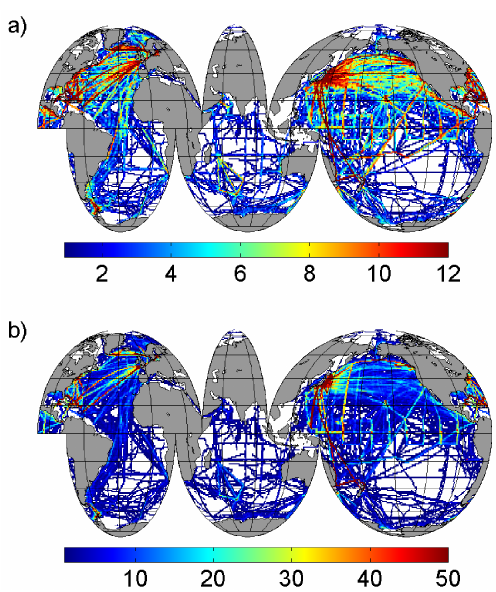
Figure 6. (a) Number of unique months and (b) total number of months with f CO 2 values per 1 ◦ × 1 ◦ grid cell for 1970 through 2014 in SOCAT version 3. Similar figures are available for versions 1 and 2 (Sabine et al., 2013; Bakker et al., 2014). The higher reso- lution of 0.25 ◦ × 0.25 ◦ , available for coastal seas (Sect. 5.5), is not